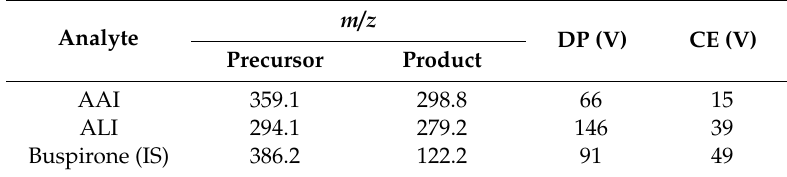
Table 2. Optimized multiple reaction monitoring (MRM) pairs and parameters for AAI and aristololactam I (ALI).